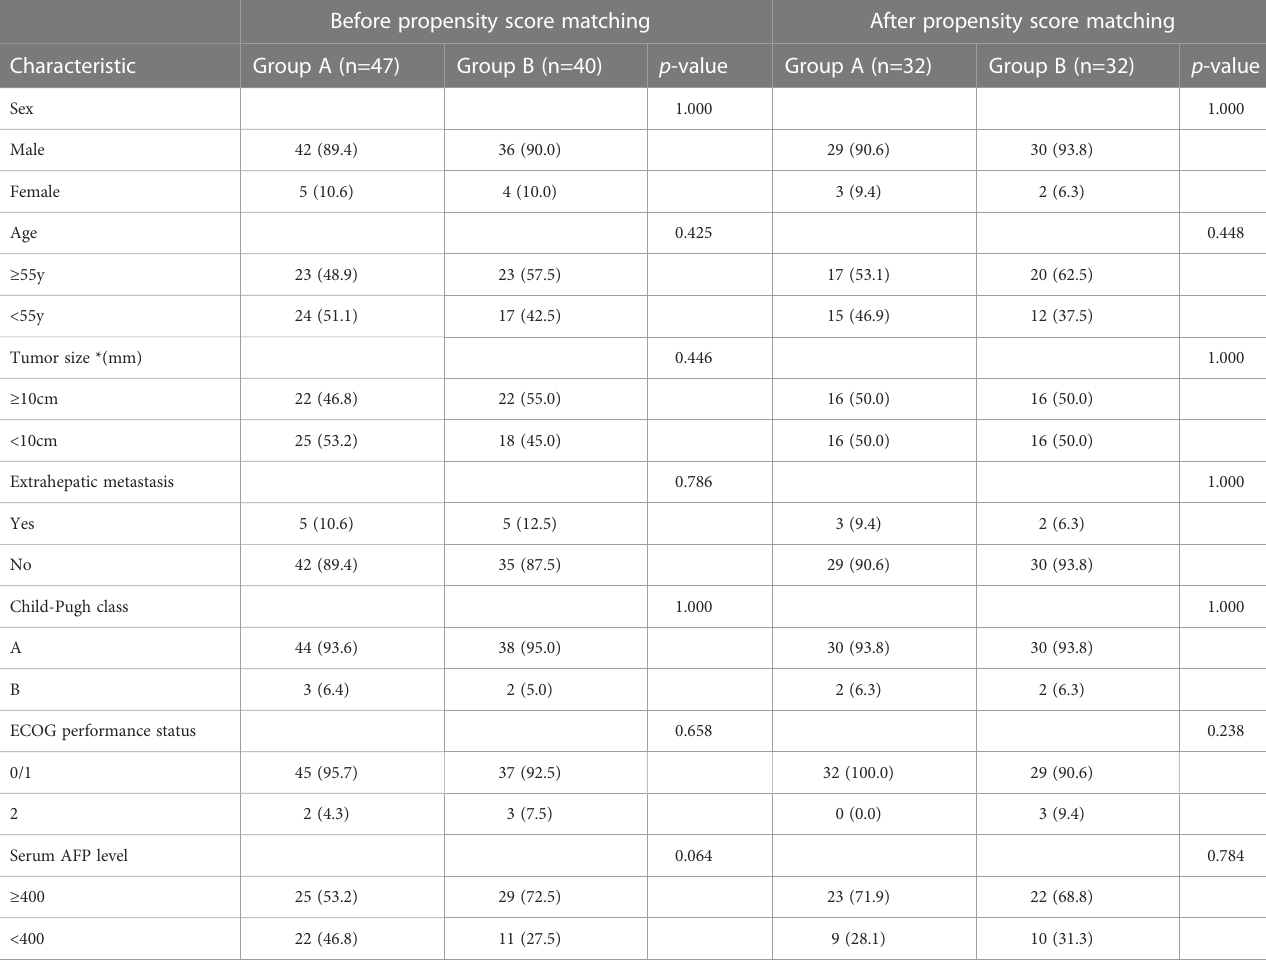
TABLE 1 Baseline characteristics of the 2 groups before and after propensity score